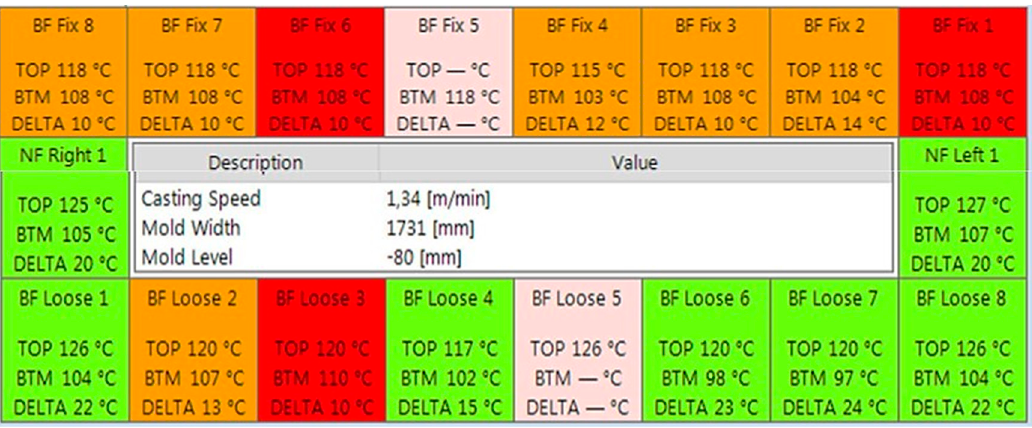
Figure 5. Arrangement of thermocouples installed in copper plates of the mold.